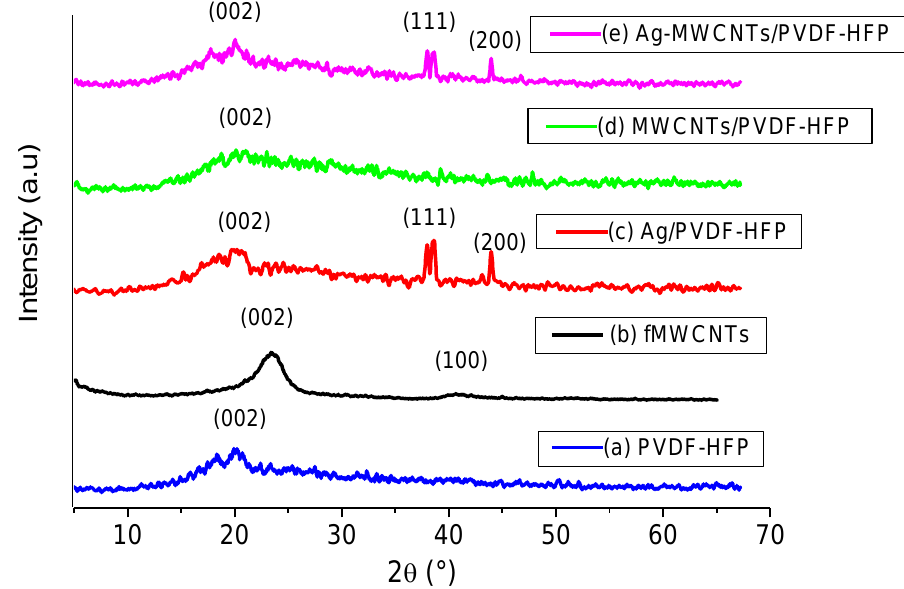
Figure 1. X-ray diffraction patterns of ( a ) poly(vinylidene fluoride-co-hexafluoropropene) (PVDF-HFP),